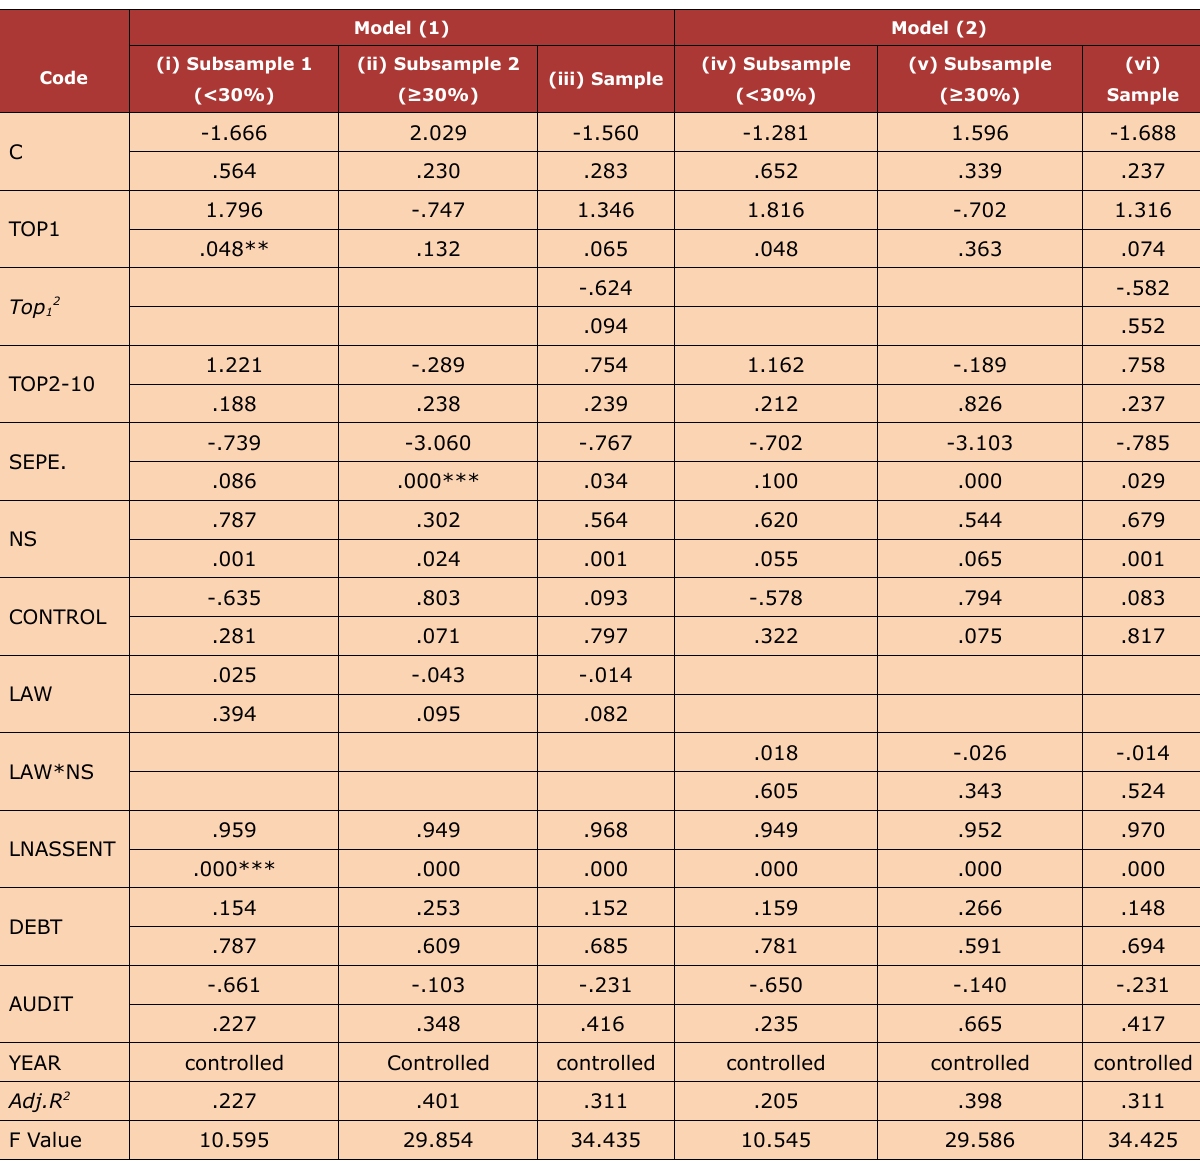
Table 4. Regression Result of Model (1),